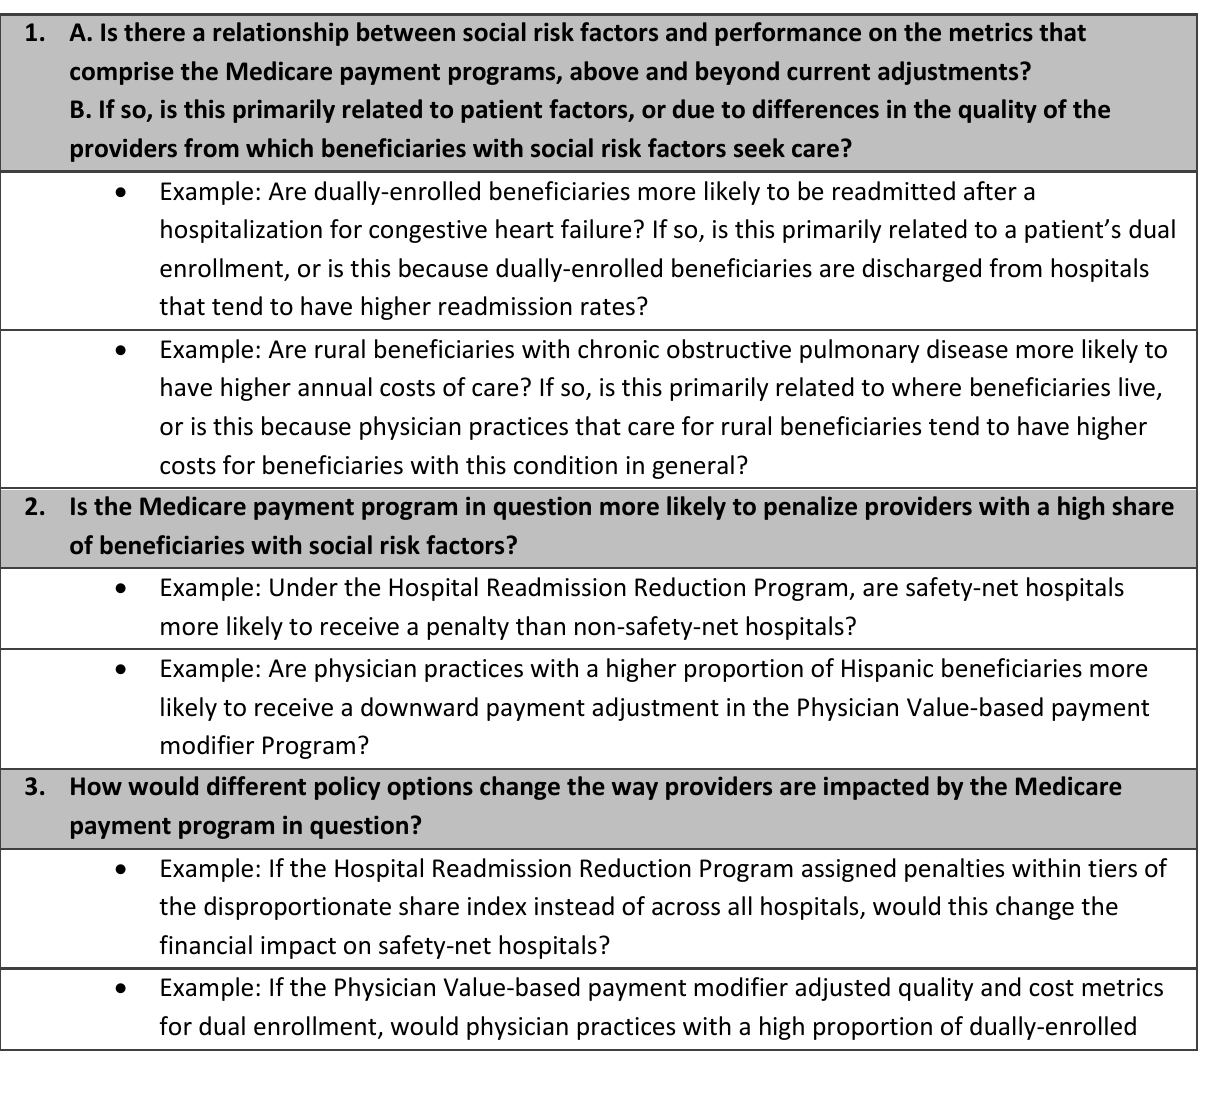
Table 3.1: Research